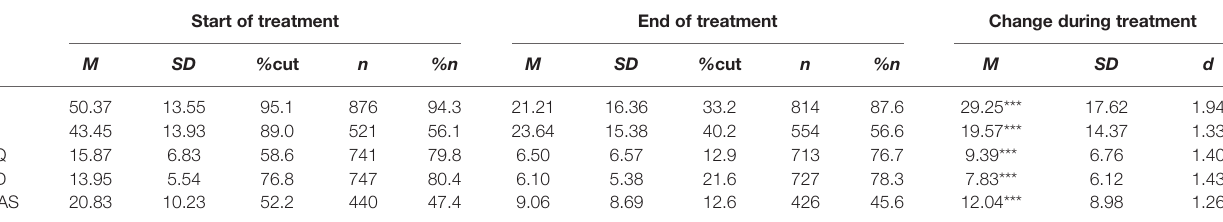
Start of treatment End of treatment